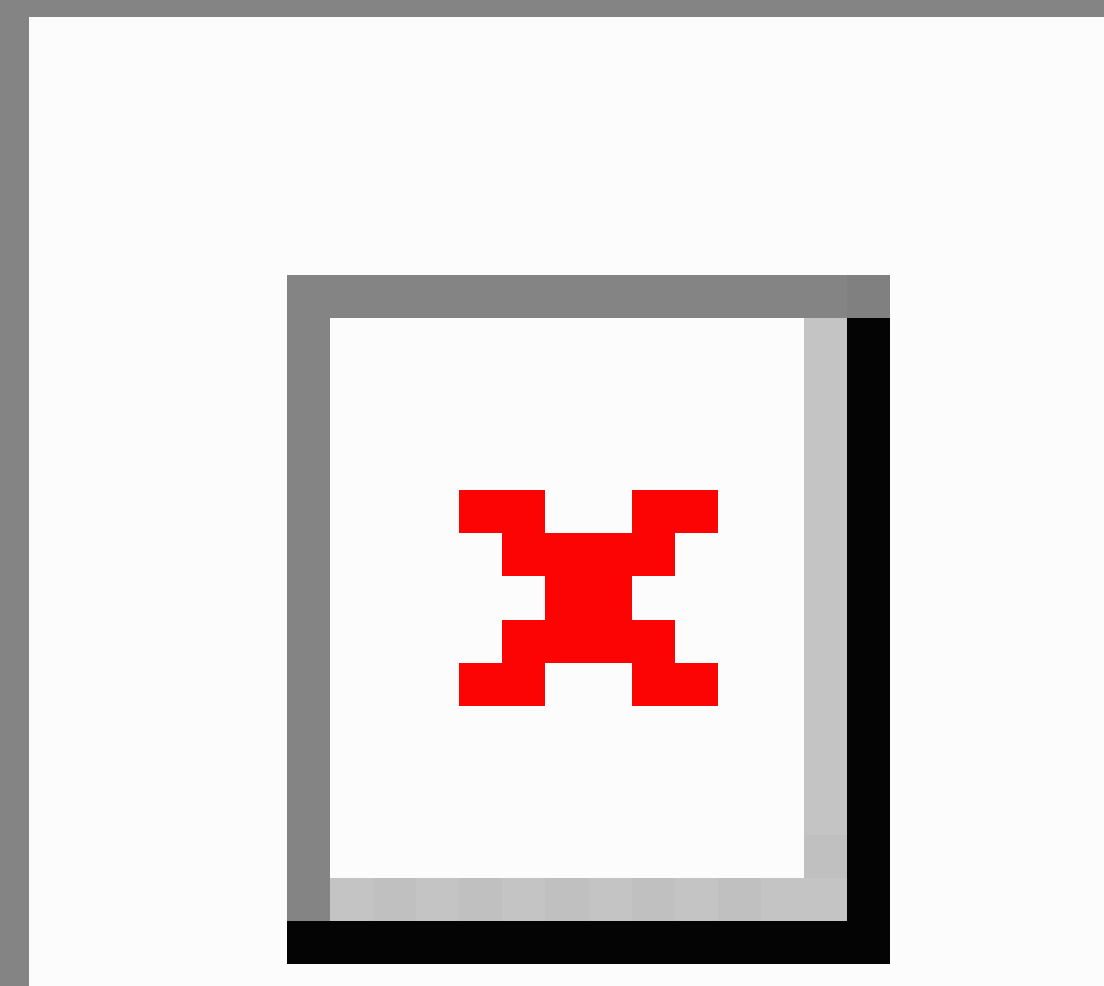
Figure 5. Regional distribution of type 2 patients and hospital (H) locations across the Kingdom. The projection scale for this map is